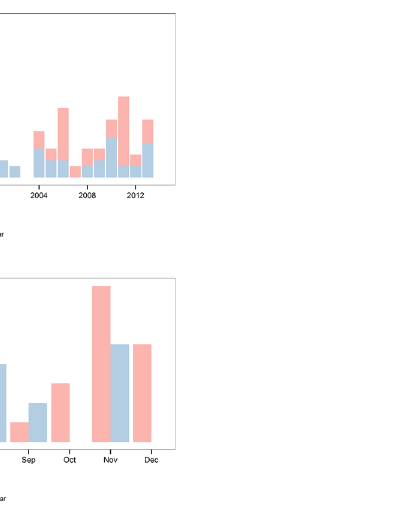
Fig 11. Stranding rates of tropical/subtropical and temperate/polar species by year (A) and month (B) from 1976 to 2013. Tropical/subtropical species: pantropical spotted dolphin, Stenella attenuata , Atlantic spotted dolphin, Stenella frontalis , rough-toothed dolphin, Fraser ’ s dolphin, Lagenodelphis hosei and Bryde ’ s whale . Temperate/polar species: Burmeister ’ s porpoise, Phocoena spinipinnis , spectacled porpoise, Phocoena dioptrica , Peale ’ s dolphin, Lagenorhynchus australis , Commerson ’ s dolphin, Cephalorhynchus commersonii , southern elephant seal, Mironga leonina , crabeater seal, Lobodon carcinophaga , Antarctic fur seal, Arctocephalus gazella , Gray ’ s Beaked whale Mesoplodon grayi , strap-toothed whale, Mesoplodon Layardii , and Arnoux ’ s beaked whale, Berardius arnuxii . Stranding records from all areas (1 – 5) were included.